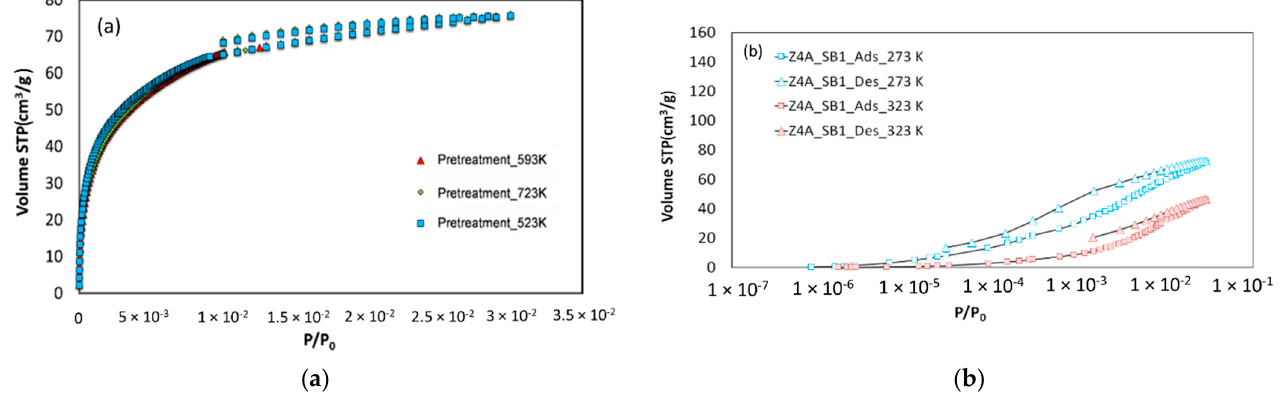
Figure 6. CO 2 adsorption–desorption isotherms on 4A zeolite in spherical beads form. ( a ) At 273 K after pretreatment at different temperatures, and ( b ) At 273 K and 323 K.